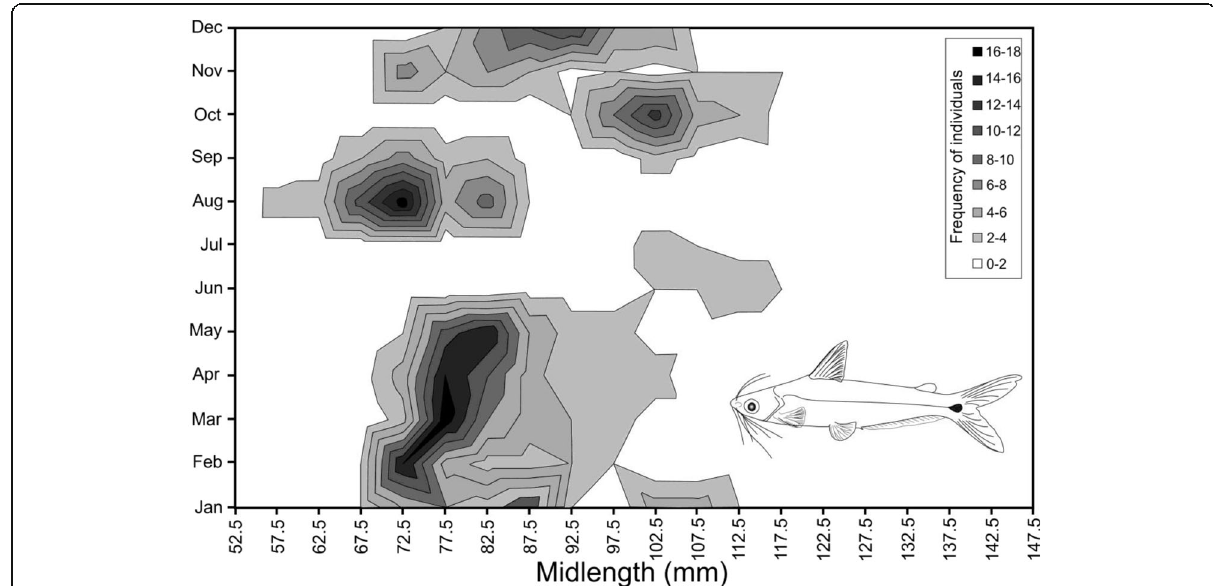
Fig. 1 Contour plot based on length – frequency analysis of Pachypterus khavalchor from the Panchaganga River collected during June 2015 to May 2016, Maharashtra, India